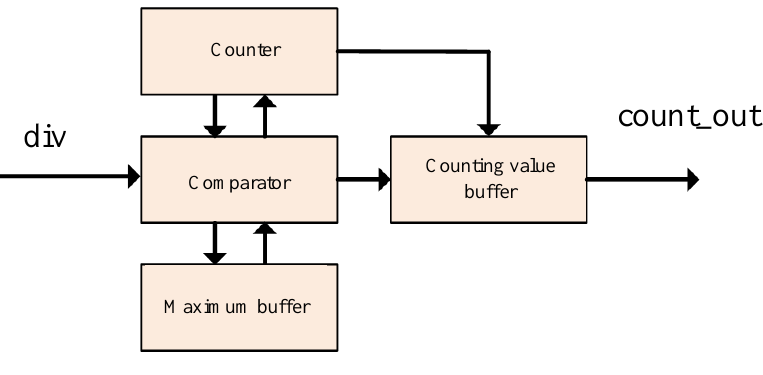
Figure 14. Peak search module design.